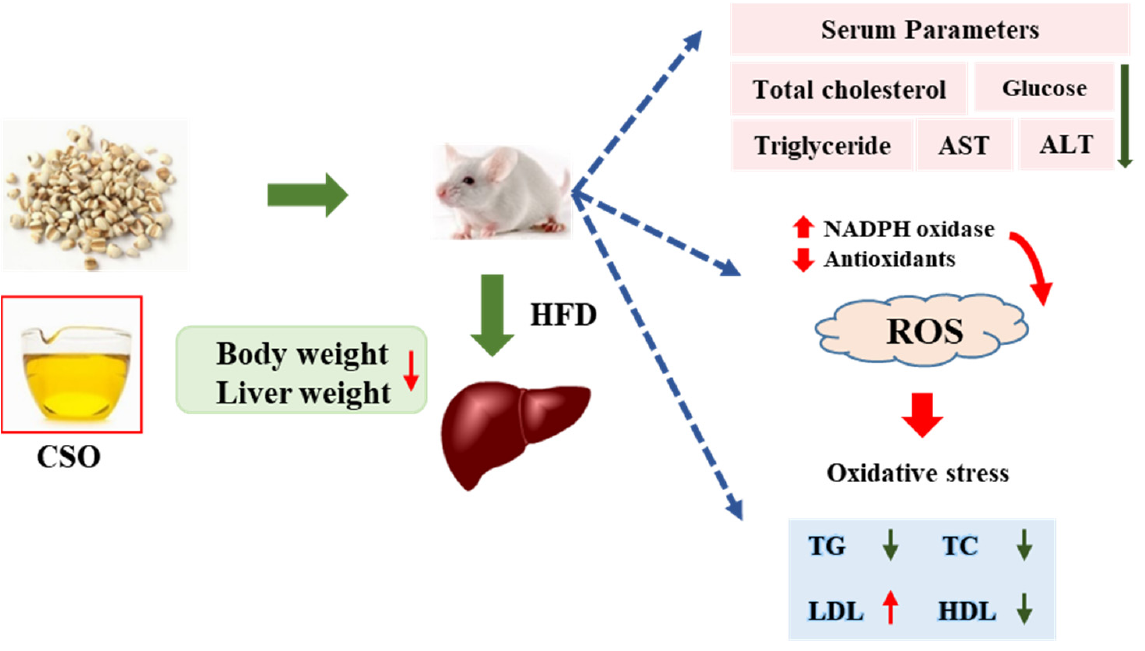
Figure 5. Schematic representation of the mechanism of action through which CSO affects obesity induced by a high-fat diet in mice.